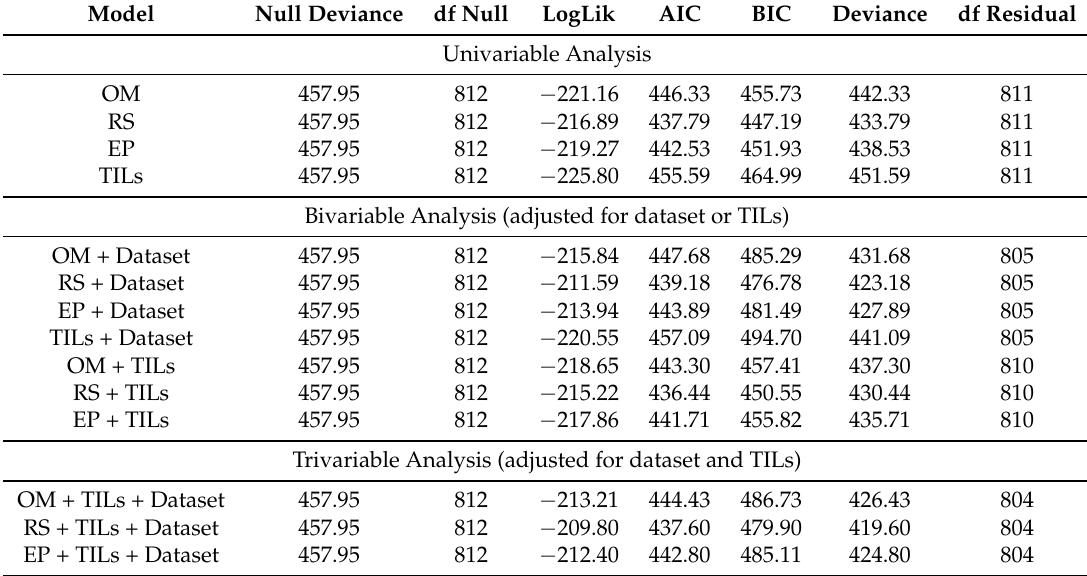
Table 4. Deviance statistic by model